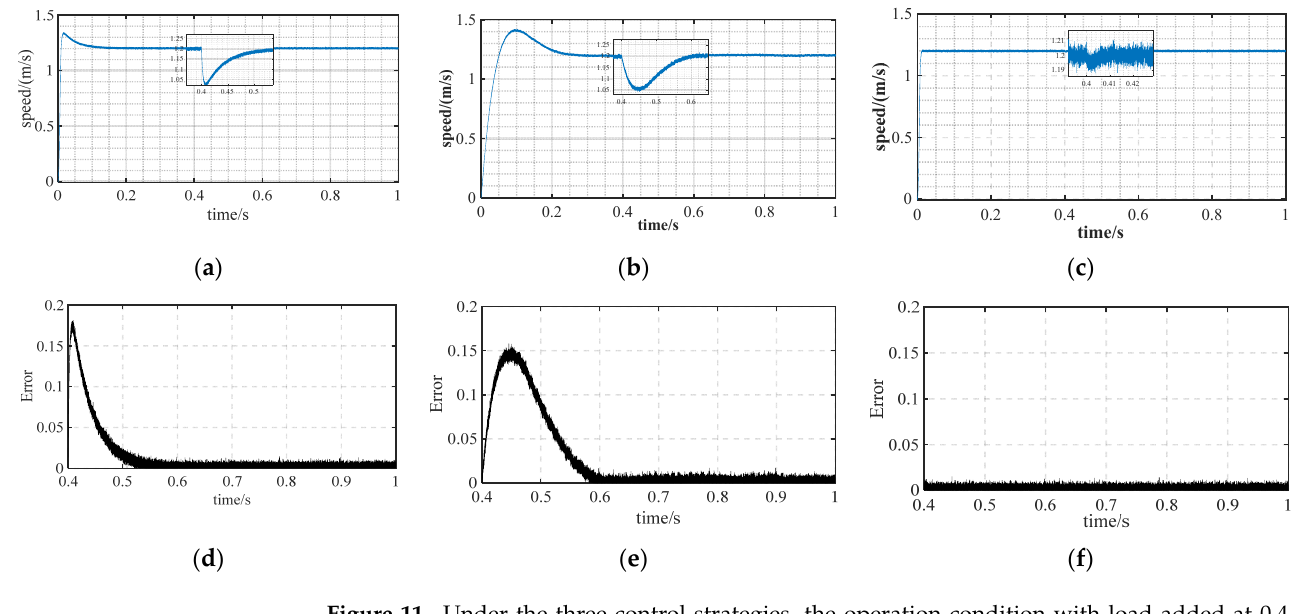
Figure 11. Under the three control strategies, the operation condition with load added at 0.4 s: ( a ) speed of PI control system; ( b ) speed of SMC control system; ( c ) speed of CT-SMC control system; ( d ) speed error of PI control system after 0.4 s; ( e ) speed error of SMC control system after 0.4 s; ( f ) speed error of CT-SMC control system after 0.4 s.